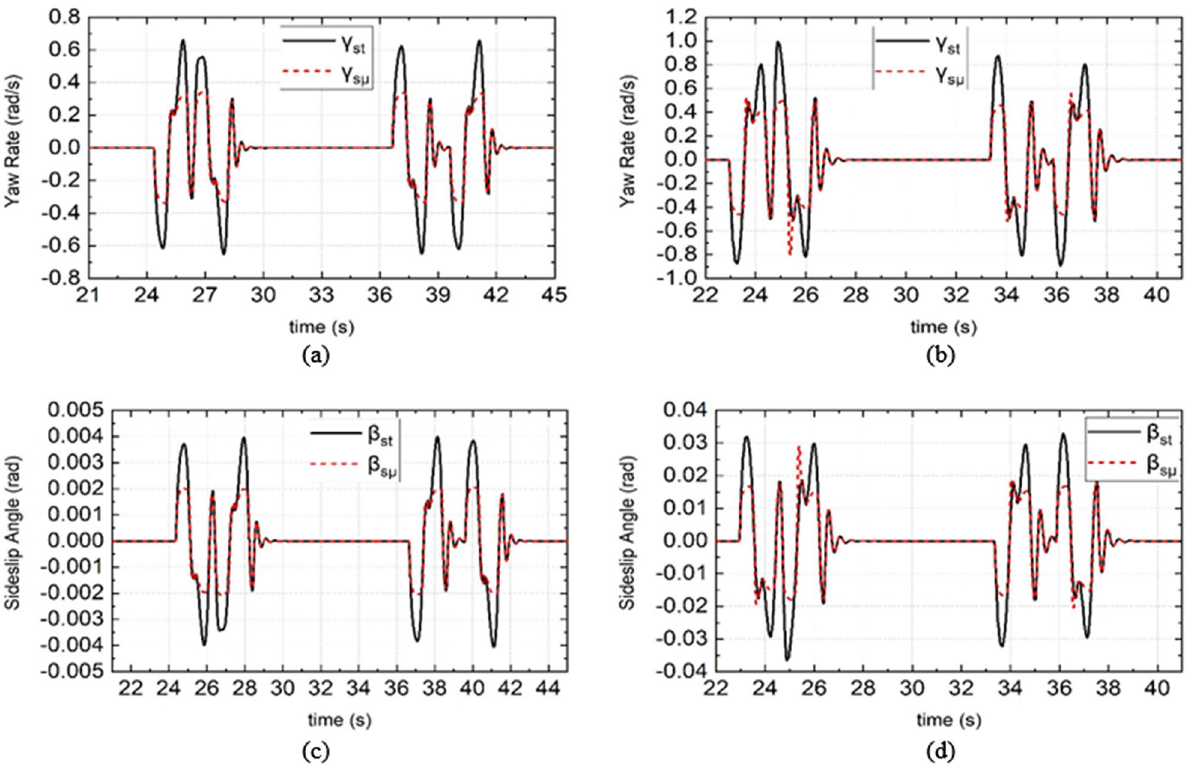
Figure 6. Simulation results of stability boundary under different road adhesion coefficient and different vehicle speed. ( a ) and ( c ) are the simulation results of DDAV running at 55 km/h on wet road, ( b ) and ( d ) are the simulation results of DDAV running at 65 km/h on dry